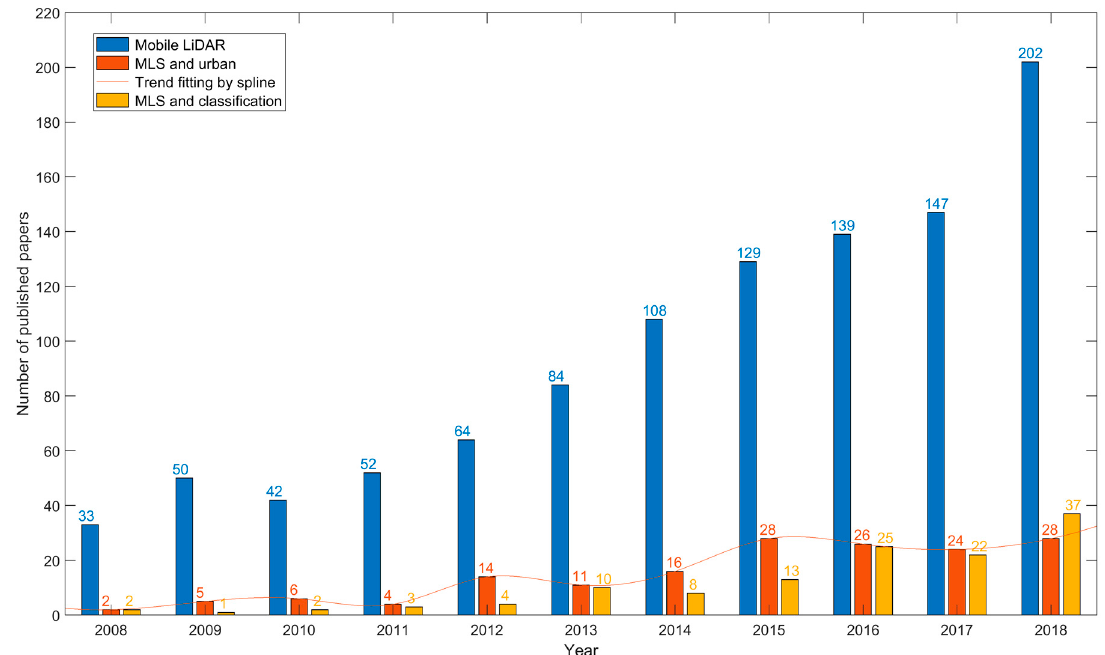
Figure 1. The number of published papers per year from 2008 to 2018. The bars and their above numbers depict the number of published papers in the according year. The blue bars represent the topic of mobile LiDAR, the red ones represent the topic of MLS and urban, and the yellow ones represent the topic of MLS and classification. The red curved line is the trend fitting of MLS and urban topic by spline data interpolation.